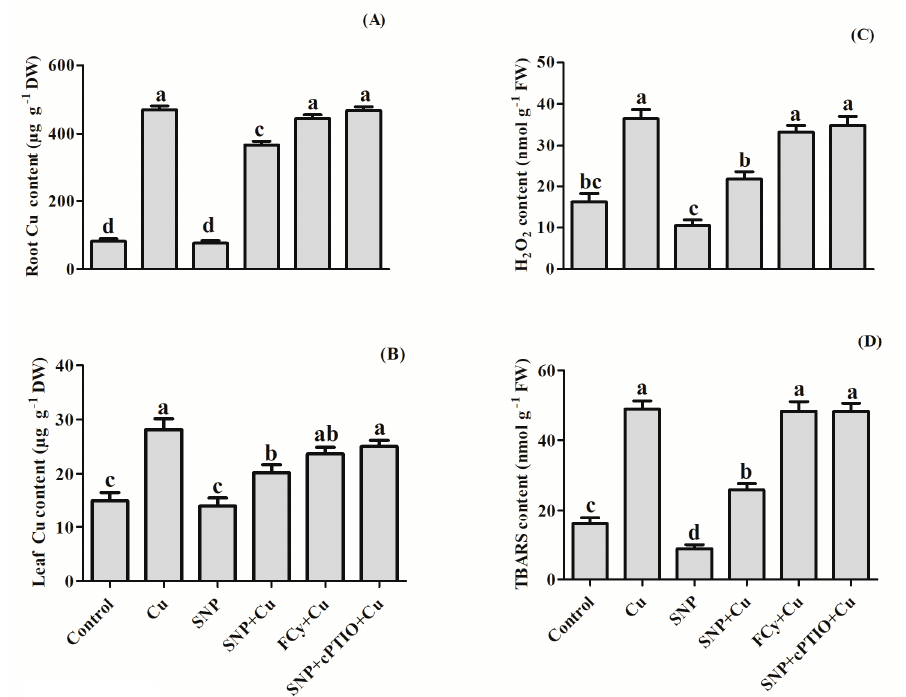
Figure 7. Contents of Cu in root ( A ) and leaf ( B ), and contents of both H 2 O 2 ( C ) and TBARS ( D ) in leaves of Indian mustard ( Brassica juncea L.) at 30 DAG. Plants were grown with/without Cu stress and treated during pre-germination for 3 h with water, SNP, FCy (SNP analogue) and SNP + cPTIO (cPTIO as a specific NO-scavenger). Same letters above bars show that data did not differ significantly by LSD test at p < 0.05. FW, fresh weight; DW, dry weight.